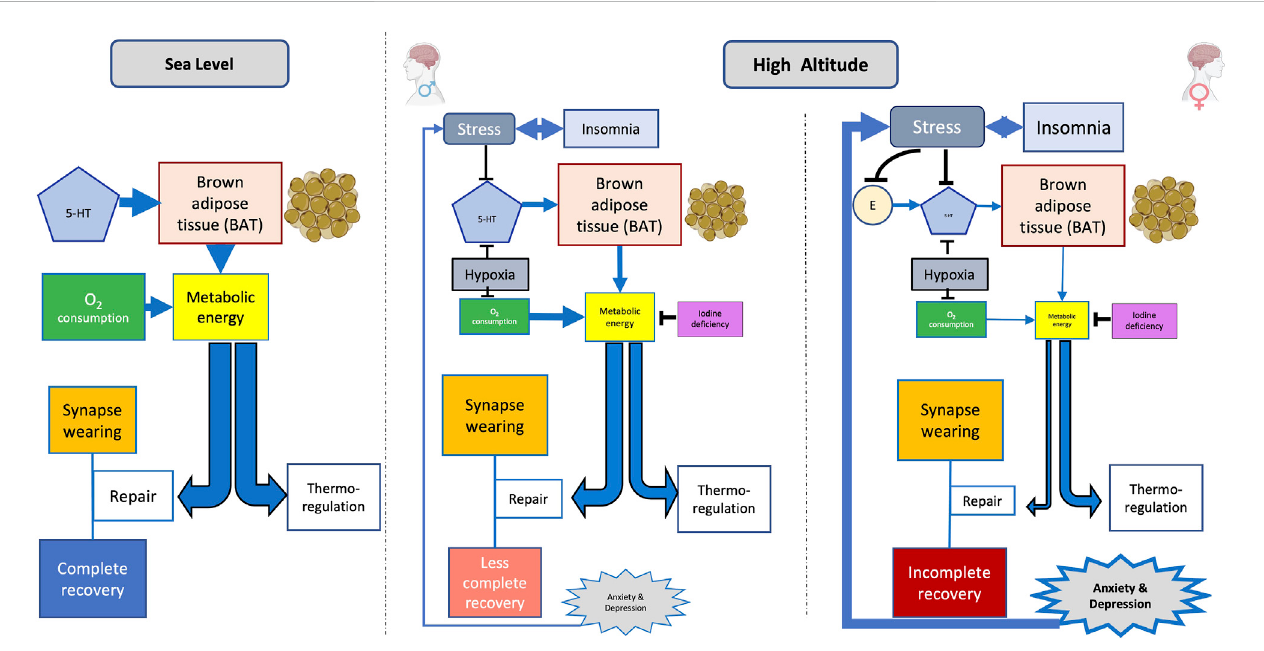
FIGURE 2 Hypothetical sex-related mental disorder on exposure to high altitude (HA). Stress and hypoxia decrease the availability of 5-HT at HA; brain synthesis of the latter already being lower in women than in men. Moreover, estrogen (E)-mediated support of 5-HT is blocked by stress. The lack of 5-HT diminishes brown adipose tissue (BAT) – dependent heat generation. Metabolic energy already being reduced by hypoxia, and possibly also by goiter, which may consequently generate a tradeoff in order to prioritize the energy requirements of thermoregulation, possibly at the expense of synapse repair. Memory consolidationtherebybeinginterferedcouldallowmoodchangestosurge;thelatter,inturn,additionallyenhancingstressandinsomnia.Aviciouscirclemay thus be installed, potentially triggering the generation of mental disorders. Line thickness indicates the magnitude of